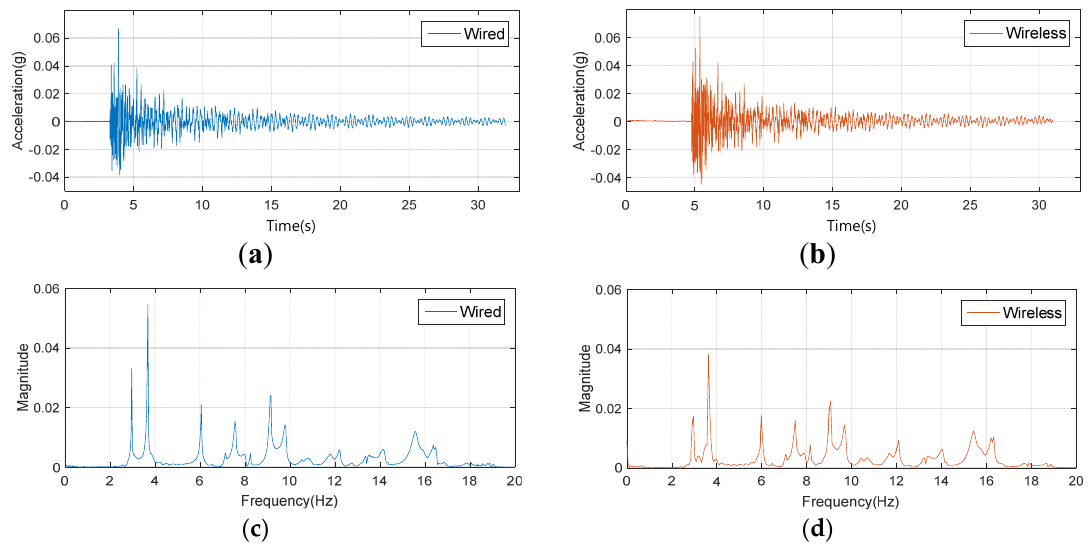
Figure 10. Results of modal test: ( a ) Wired time domain; ( b ) wireless time domain; ( c ) wired frequency domain; ( d ) wireless frequency domain.